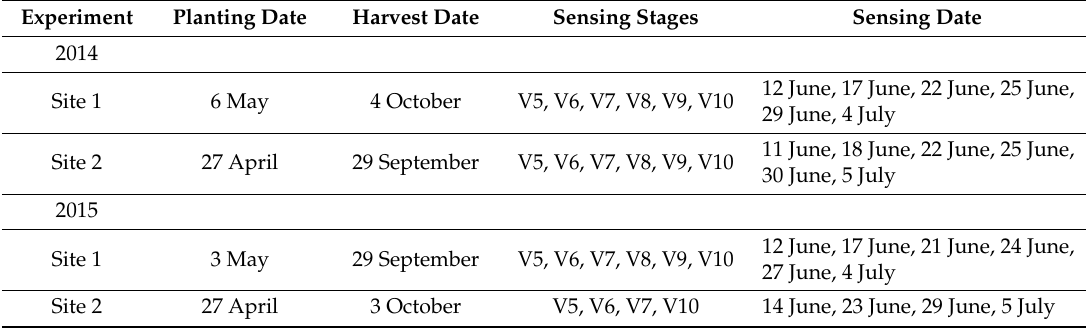
Table 1. Detailed information about the experiments conducted in this study in 2014 and